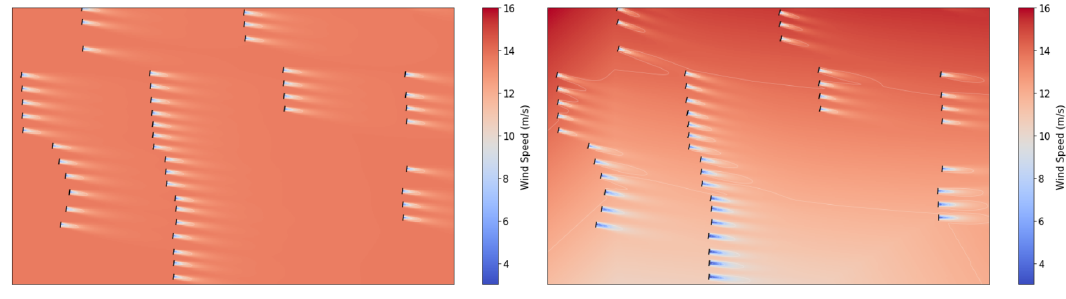
Figure 16. Horizontal planes of two different FLORIS simulations, taken at the same time-step iteration.